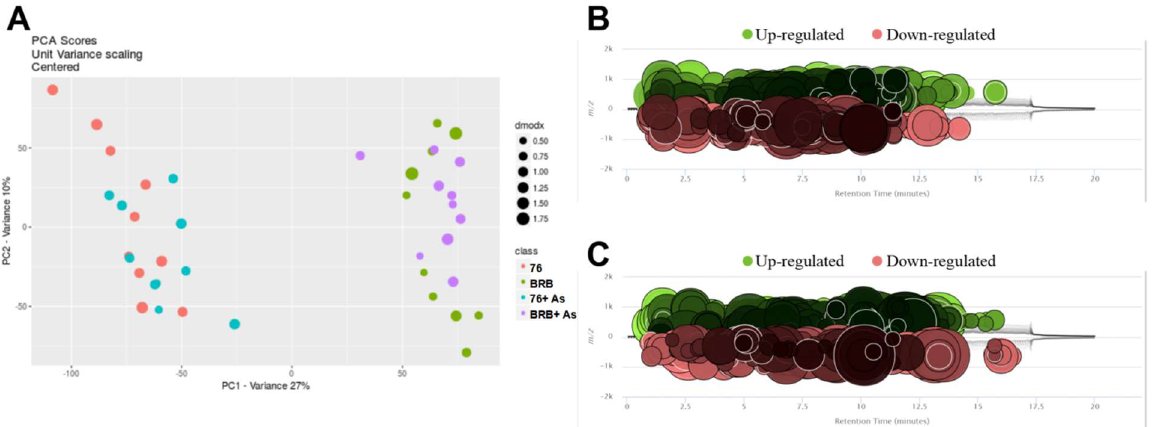
Figure 3. Comparative analysis of metabolite profiles. ( A ) PCA plot of four groups. Cloud plots constructed by altered features with green bubbles representing up-regulated features and red bubbles representing down-regulated features, 76 group versus BRB group ( B ), 76+ As group versus BRB+ As group ( C ).